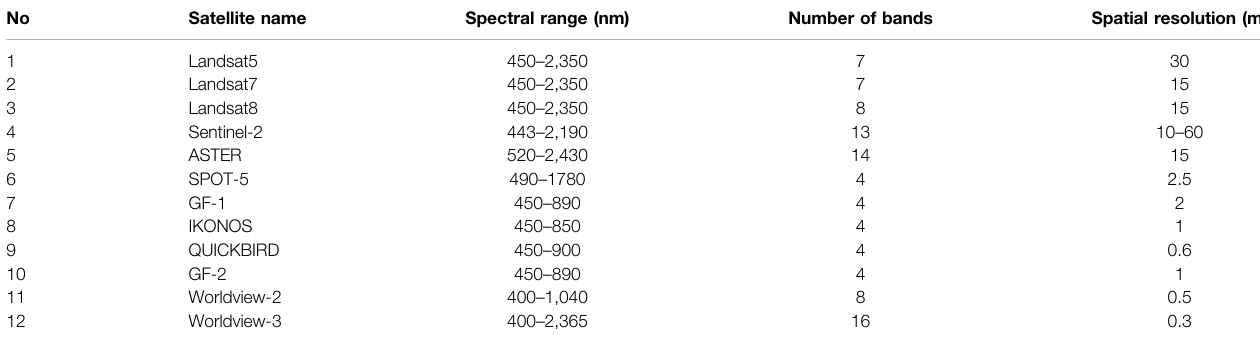
TABLE 1 | The basic information of different remote sensing